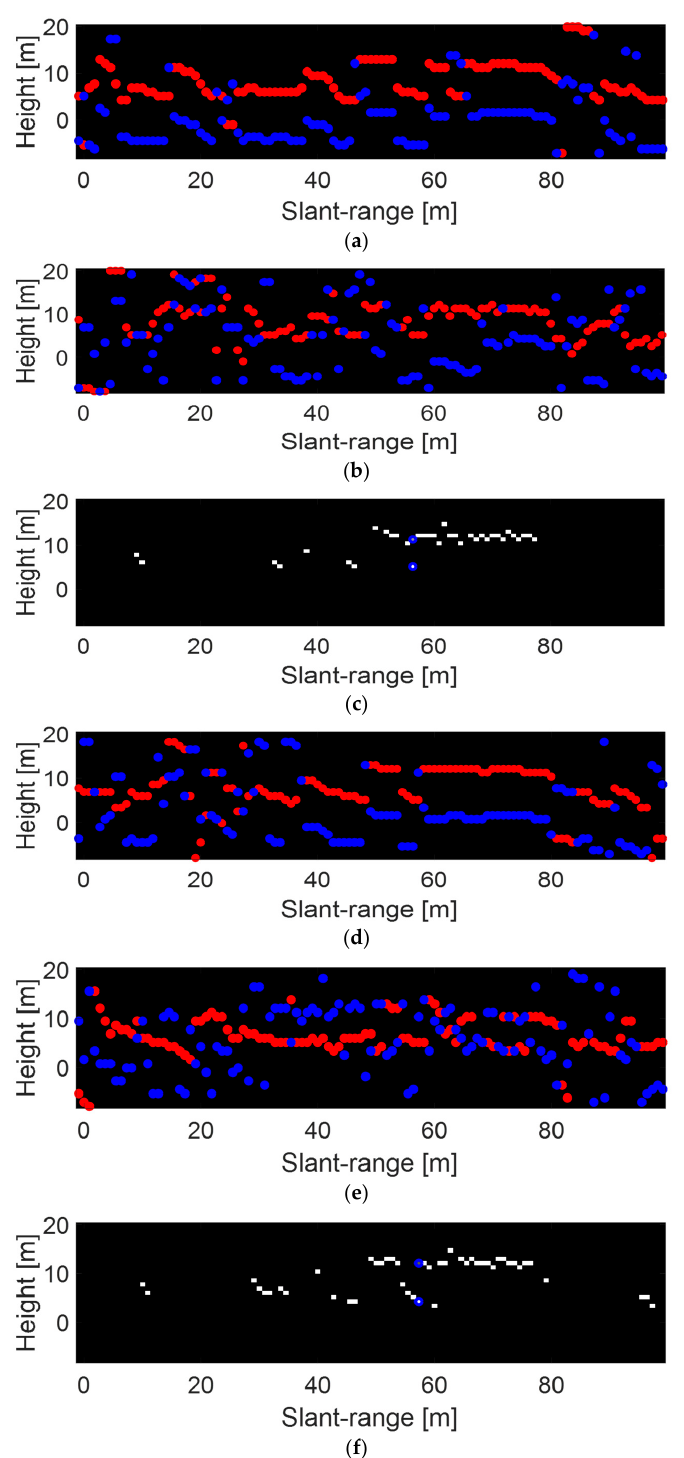
Figure 10. Tomographic slices obtained with polarimetric beamforming ( a , d , g ), Capon ( b , e , h ) and Fast-Sup-GLRT ( c , f , i ) respectively, from top to down, for line A, B, and C. Blue circles indicate the double scatterers for the Fast-Sup-GLRT, and red and blue points respectively indicate the first and second peaks of the beamforming and Capon